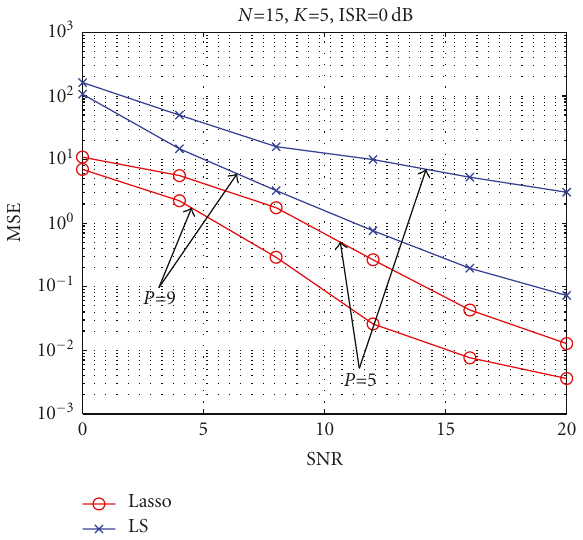
Figure 3: Mean-square error of the users’ time delay versus SNR in a power-controlled scenario (chip-synchronous system with AWGN and known K ).